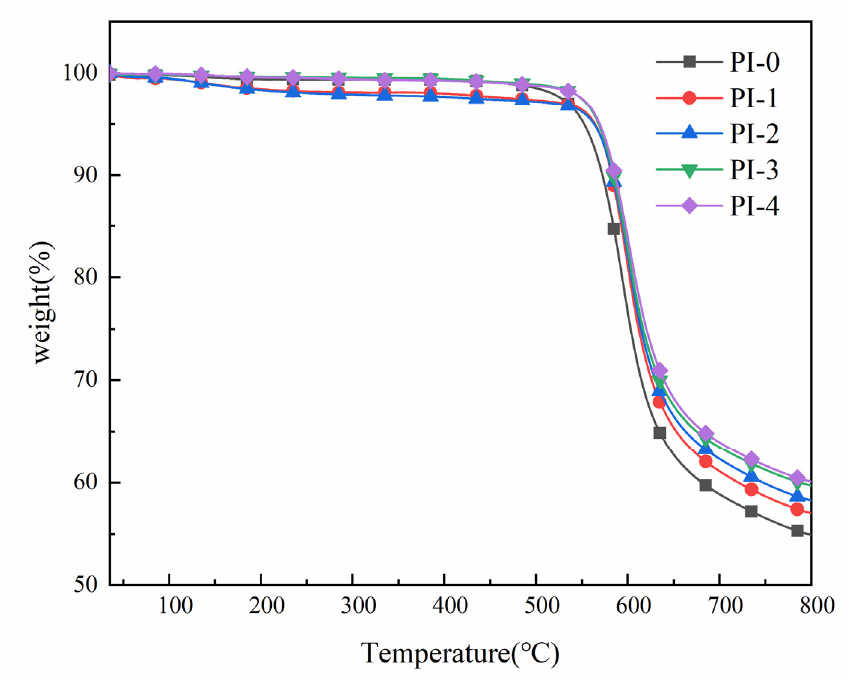
Figure 5. TGA curves of the PI films. Table 4. Thermal and mechanical properties of PI